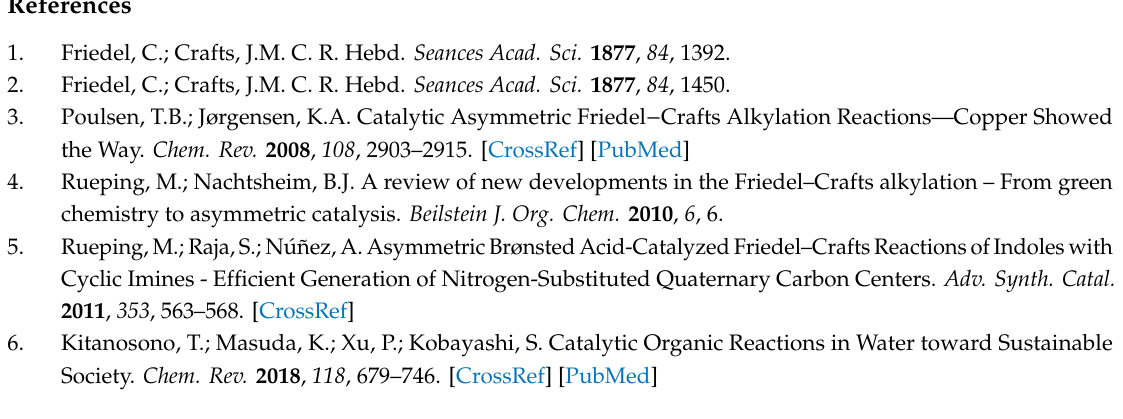
s1, Figure S1: HPLC chromatograms of modified oligonucleotides [2,3], Figure S2: CD-spectra of c-kit(wt) Figure S3: CD-spectra of c-kit oligonucleotide modified at position 10 in 20 mM MOPS (pH = 7) + 100 mM KCl. All formed G-quadruplexes [2,3], Figure S4. Folding of di ff erent G-quadruplex and dsDNA sequences in the presence of Cu(II), Table S1: Friedel-Crafts alkylation reaction using di ff erent catalytic conditions [a], Table S2:Friedel-Crafts alkylation reaction using di ff erent catalytic conditions